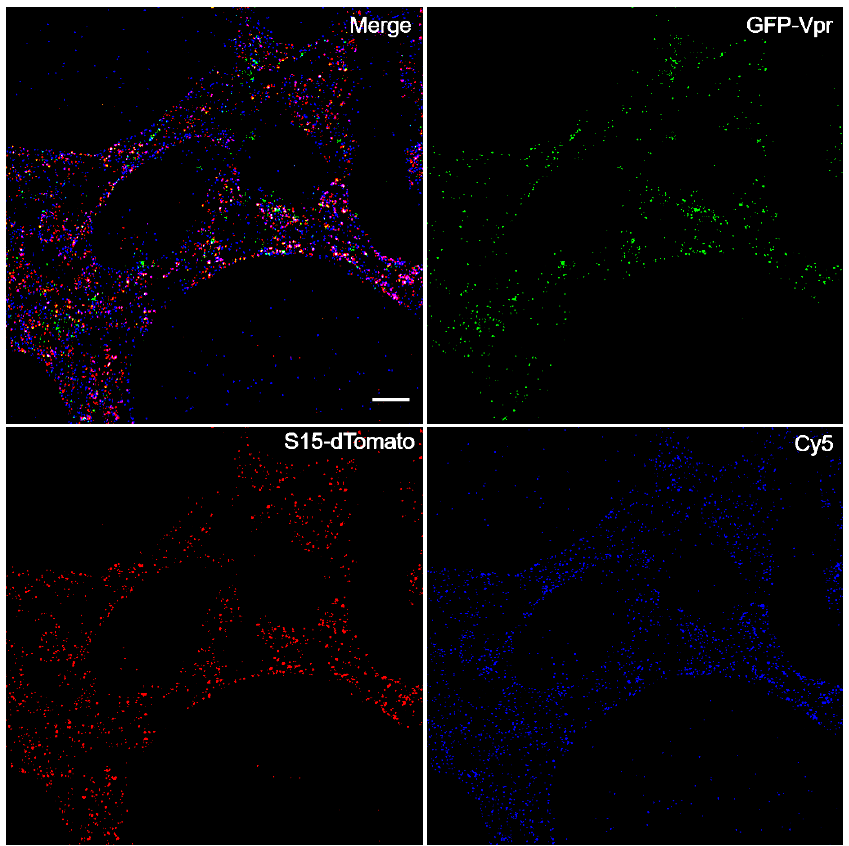
Figure 2. Representative image of the in situ uncoating assay. CHME3 cells were infected with dual-labelled VSV g HIV-GFP before fixing and imaging. GFP signal is represented in the green channel. The dTomato fusion marker is shown in red. Antibody capsid stain is visible in the blue channel representing a pseudocolored Cy5 signal. The white scale bar in the Merge panel is 10µm. Image brightness has been enhanced for signal visibility.